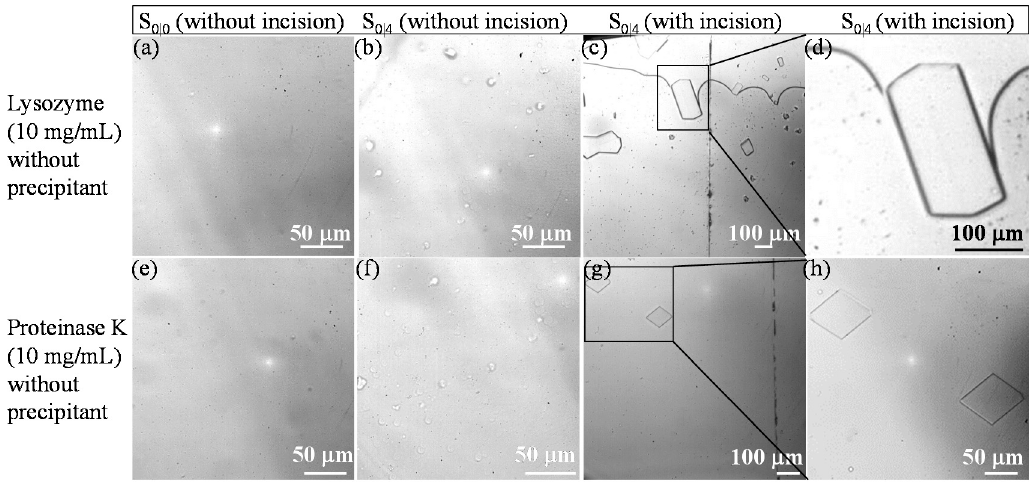
Figure 3. The optical micrographs summarize occurrence of crystals of lysozyme and proteinase K on set I and set II substrates. The concentration of both proteins in respective buffer was 10 mg/mL. Crystals did not appear on set I (images a and e ) and set II (images b and f ) substrates devoid of any incision. However, crystals of both lysozyme and proteinase K appeared on set II substrates (images c and g ) which were decorated with incision. Small portions in images (c) and (g) are magnified in ( d ) and ( h ), respectively to show that these crystals were plate shaped without any visible third dimension.